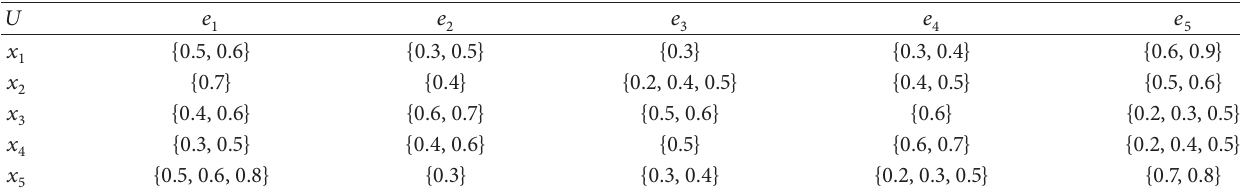
(̃𝐹,𝐴) in Example 35.